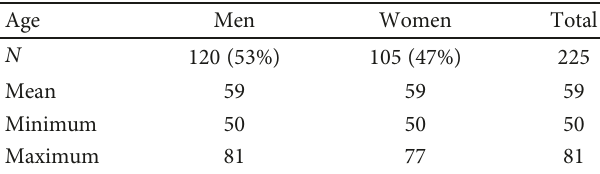
Figure 1: Comparison of the lesions diagnosed with CCE2 and CC ((a) polyp, CCE2; (b) polyp, CC; (c) cancer CCE2; (d) cancer, CC); CCE2: second-generation colon capsule endoscopy; CC: conventional colonoscopy, source: Department of Gastrointestinal Endoscopy, Military University Hospital Prague. Table 2: Clinical characteristics of analysed